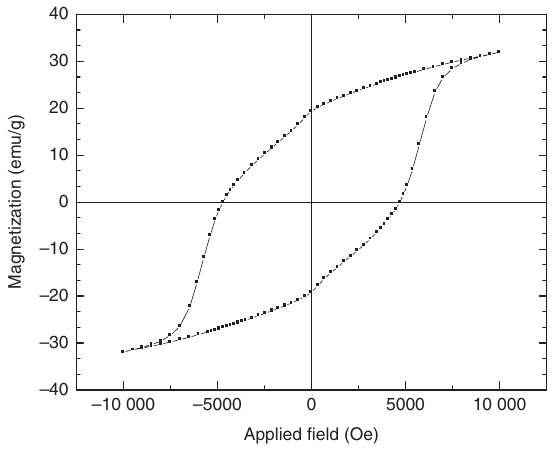
Figure 14: Magnetization loop of SrFe